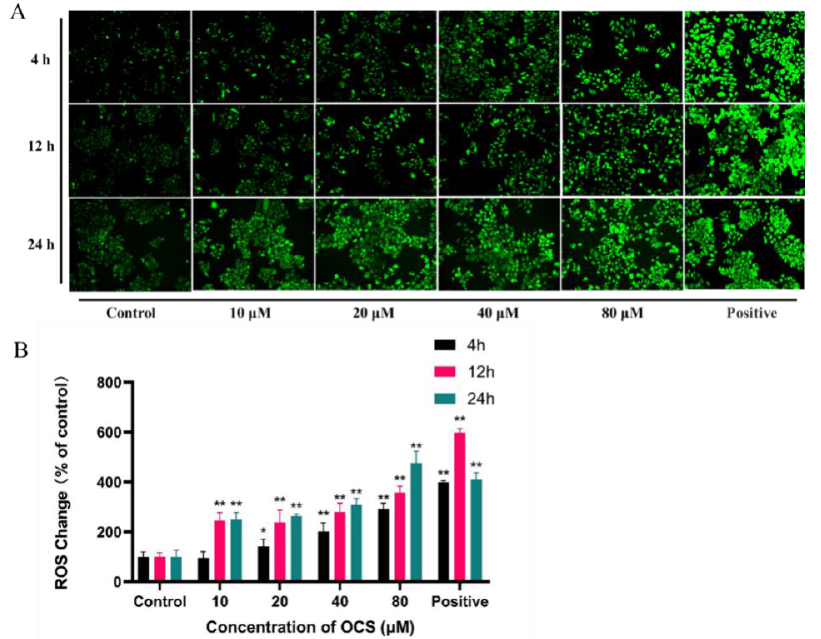
Figure 2. The image ( A ) and change ( B ) of intracellular ROS generation was detected by DCHF-DA after treatment with OCS for 4 h, 12 h, and 24 h. Each value represents the mean ± S.D. of three independent experiments ( n = 3) (* p < 0.05 vs. control, ** p < 0.001 vs.